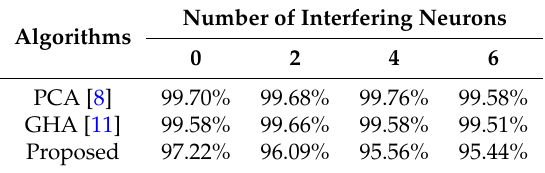
Table 8. The CSRs of the various feature extraction algorithms for different number of interfering neurons. The spike source data are obtained by the simulator in [18].